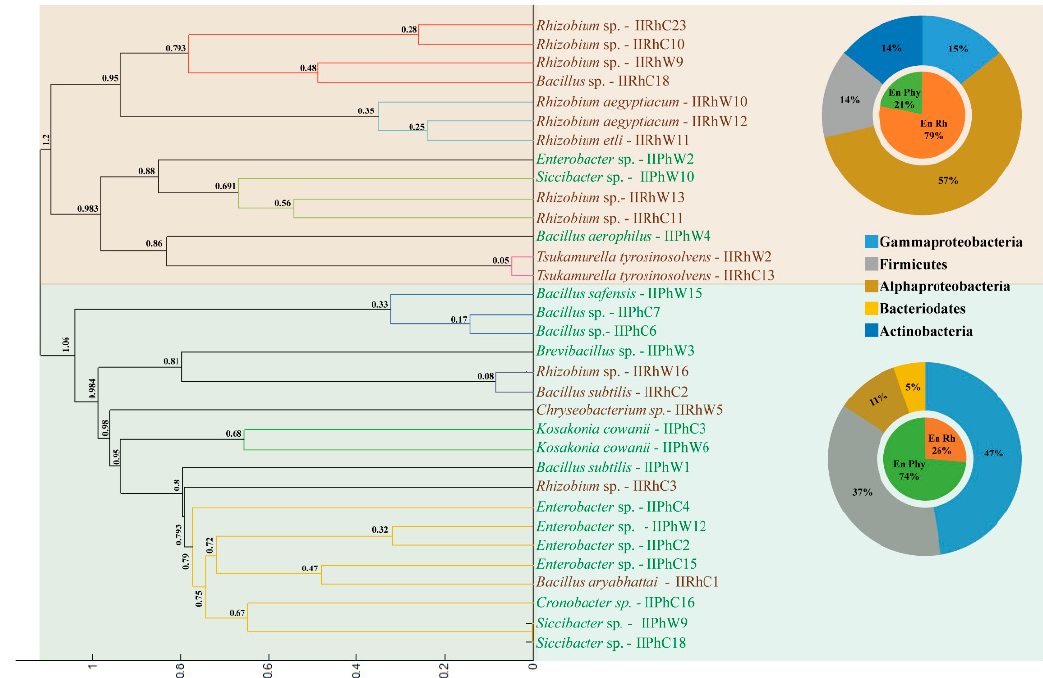
Figure 6. Cluster analysis of matrix ‐ assisted laser desorption/ionization time ‐ of ‐ flight mass spectrometry (MALDI ‐ TOF MS) spectra of all tested isolates recovered from clover endo ‐ rhizosphere (in brown), and endo ‐ phyllosphere (in green), isolated on either clover or wheat broth culture media. Potential species of isolates are indicated based on 16S rRNA gene sequencing. Distinguished are two main clusters, the brown colored background represents isolates mainly originating from the rhizosphere, and the green colored background highlights isolates mainly originating from the phyllosphere. Pie charts represent the percentages of distribution based on either plant sphere (inner pie; EnRh, endo ‐ rhizosphere; EnPhy, endo ‐ phyllosphere) and taxonomic level (outer ring, different taxa ‐ related colors).